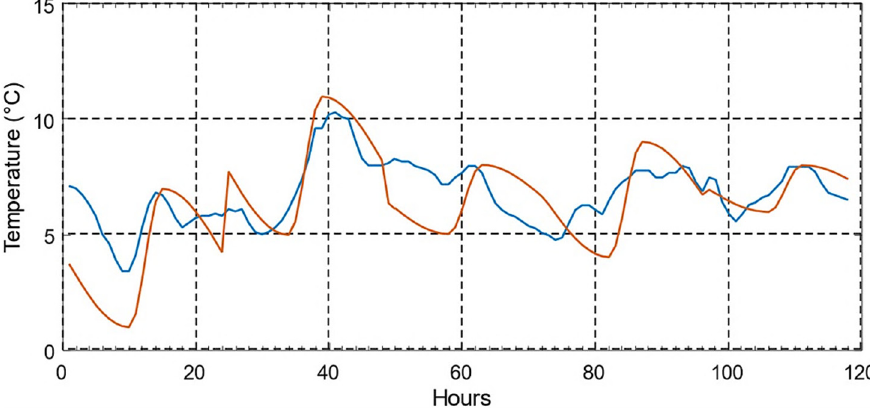
Figure 39. The Wave model simulates the daily ambient temperature cycle for the first five days of November.